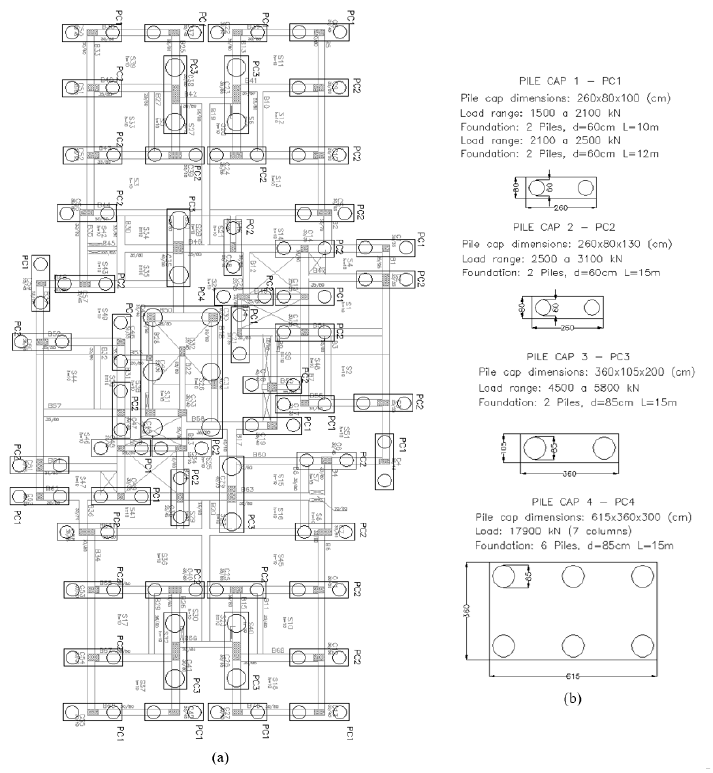
Figure 6. Foundations: (a) Floor plan; (b) Pile caps grouping by load ranges.